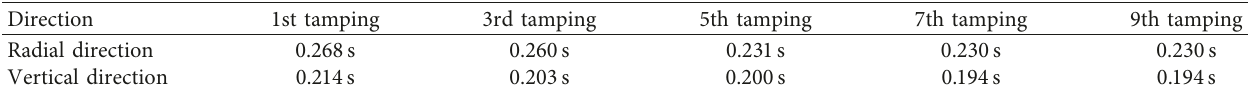
Figure 5: Vertical vibration velocity histories at 80 m distance under different times of tamping. Table 1: Occurrence time of PGV at 80m